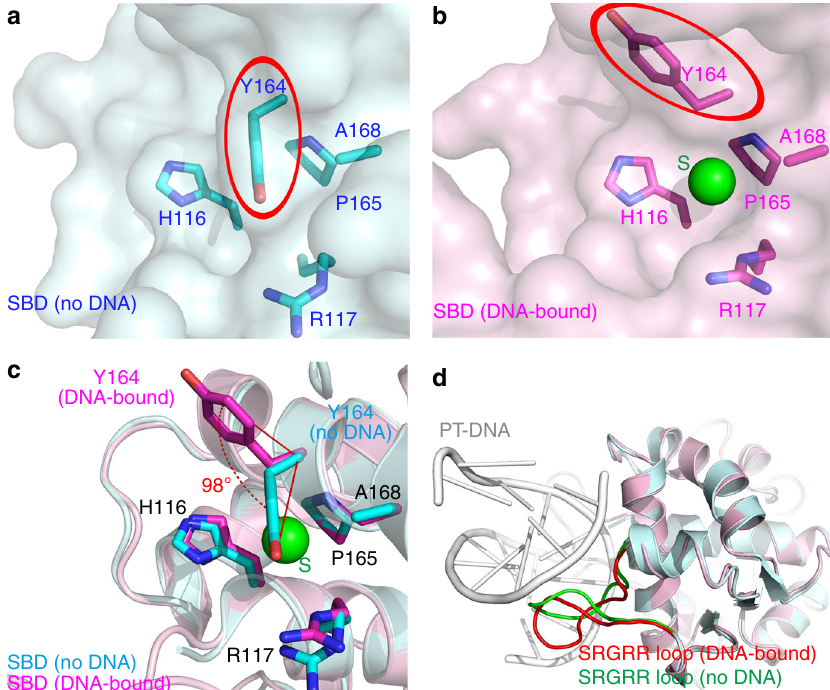
Fig. 3 ScoMcrA-SBD undergoes conformational change upon recognition of PT-DNA. a In the PT-DNA-unbound state of ScoMcrA-SBD, the phenyl ring of the side-chain of ScoMcrA-Y164 covers the sulfur-binding cavity. b In the PT-DNA-bound state, the hydroxyphenyl group of Y164 is fl ipped open to allow the sulfur atom of PT-DNA to access the sulfur-binding cavity. c Comparing the PT-DNA-bound and PT-DNA-unbound states of ScoMcrA-SBD, the hydroxyphenyl group of Y164 is rotated 98° upon association of PT-DNA. d Association of PT-DNA also triggers a substantial conformational change of the “ S 187 RGRR 191 loop ” of